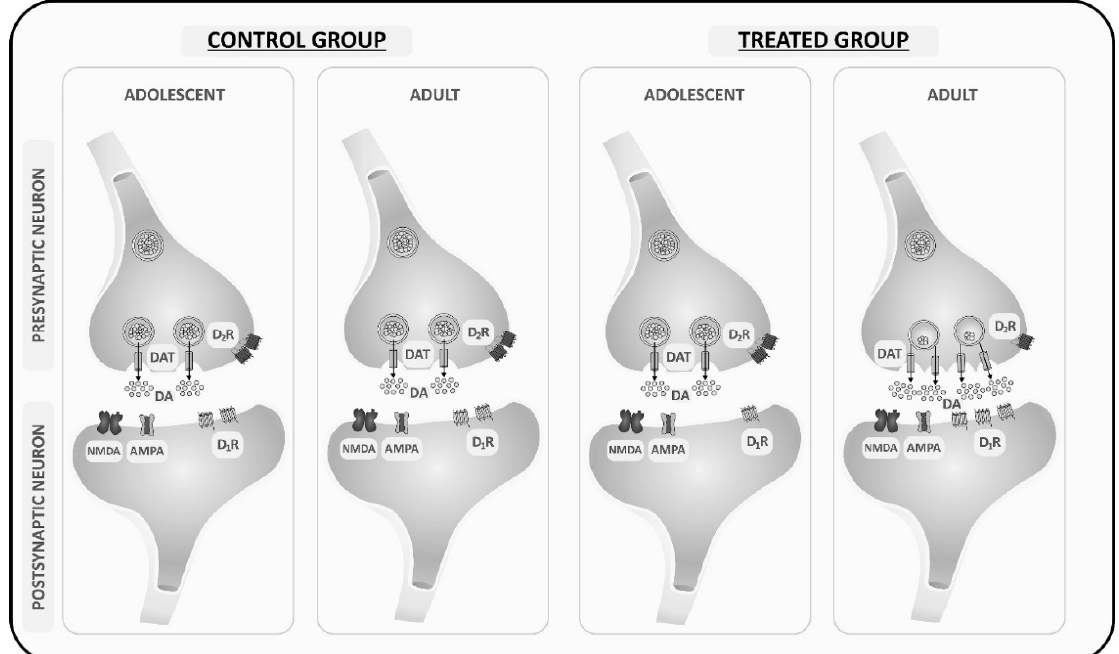
Figure 5. Schematic representation of changes in the level of DAT, D 1 and D 2 but not AMPA and NMDA receptors by prior nicotine and alcohol exposure, leading to altered amphetamine-induced stated-dependent CPP in adults versus adolescent mice. Amphetamine induced a comparable CPP under a drugged state in control adolescent and adult mice because the level of dopamine transporter (DAT) and dopamine (D 1 and D 2 ) receptors are not different between mice of the two age groups. On the other hand, the greater expression of DAT and D 1 receptors and reduced levels of D 2 receptors in adult than adolescent mice led to a greater CPP response under the drugged state in adult rather than adolescent mice with prior nicotine and alcohol experience.